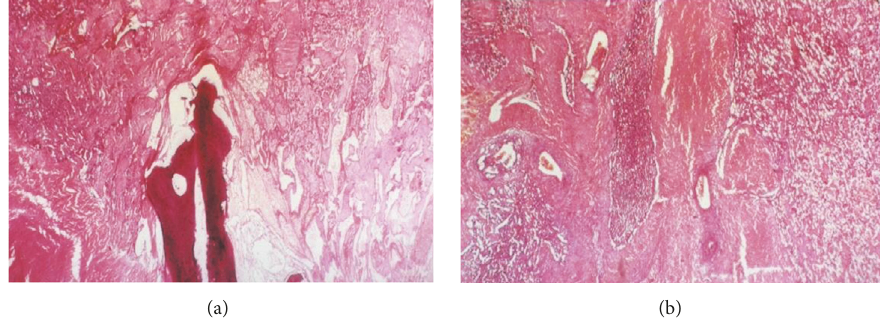
Figure 4: (a) (HE × 10) Vascular formations between osseous and collagenous structures, angiomatosis, and papillary endothelial hyperplasia. (b) (HE × 10) Angiomatosis with vessels of various sizes involving muscle, fat, and bone tissue. A lesion consisted of a collection of large venous and capillary sized vessels scattered haphazardly throughout the soft tissue, striated muscle, and spongious bone. There are also thrombi in formation in some vessels showing papillary endothelial